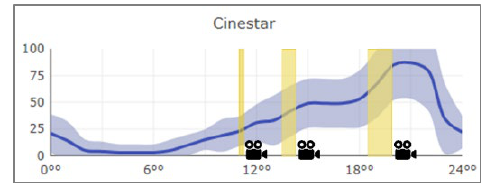
Figure 2: Increasing parking occupancy before film